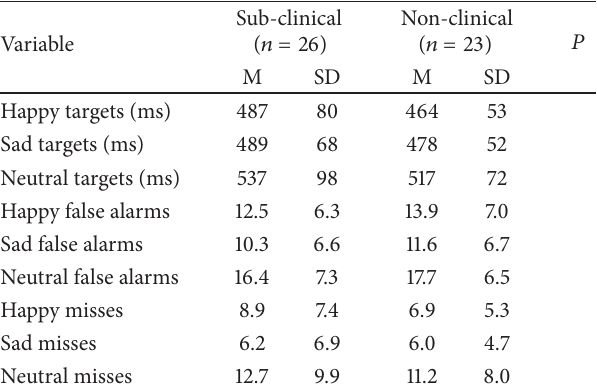
Table6:Meansandstandarddeviationsinthesub-clinicalandnon- clinical groups for the AGN task